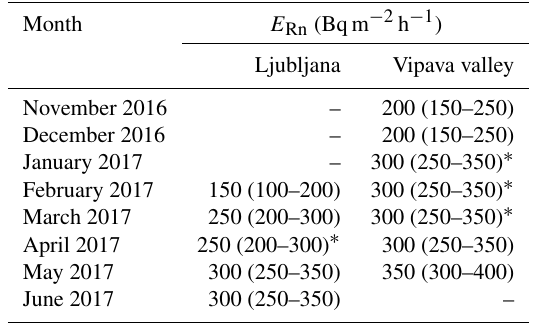
Table 2. Selected Rn exhalation rates ( E Rn ) and the range ( E Rn − min – E Rn − max ) for each month for both measurement loca-